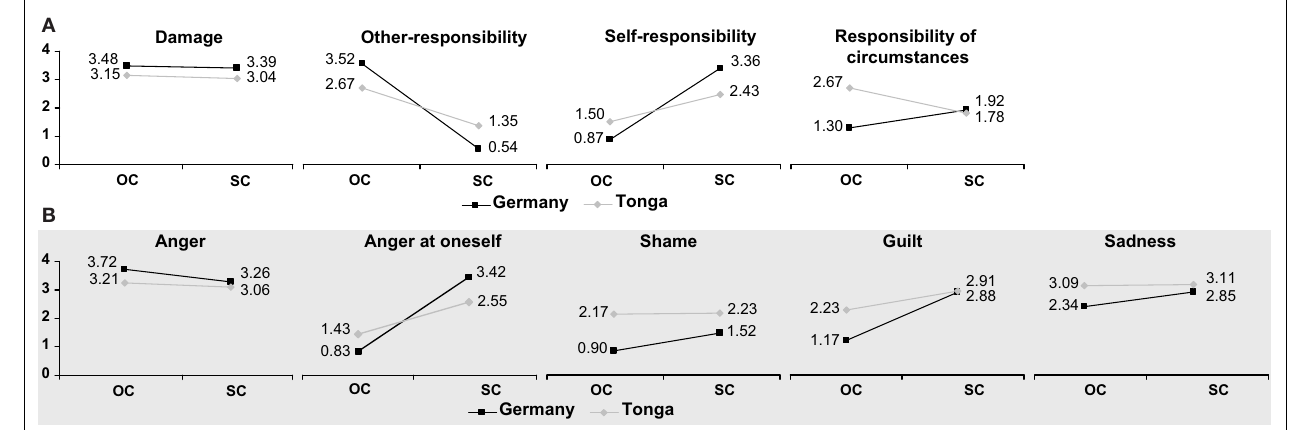
FIGURE 5 | Intensity ratings of (A) appraisal dimensions and (B) emotional responses for the other-caused (OC) vs. self-caused (SC) scenario as a function of culture and scenario.